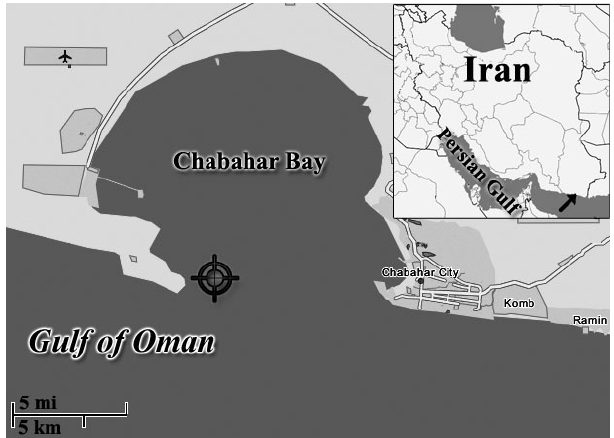
F IGURE 1. The Chabahar Bay.